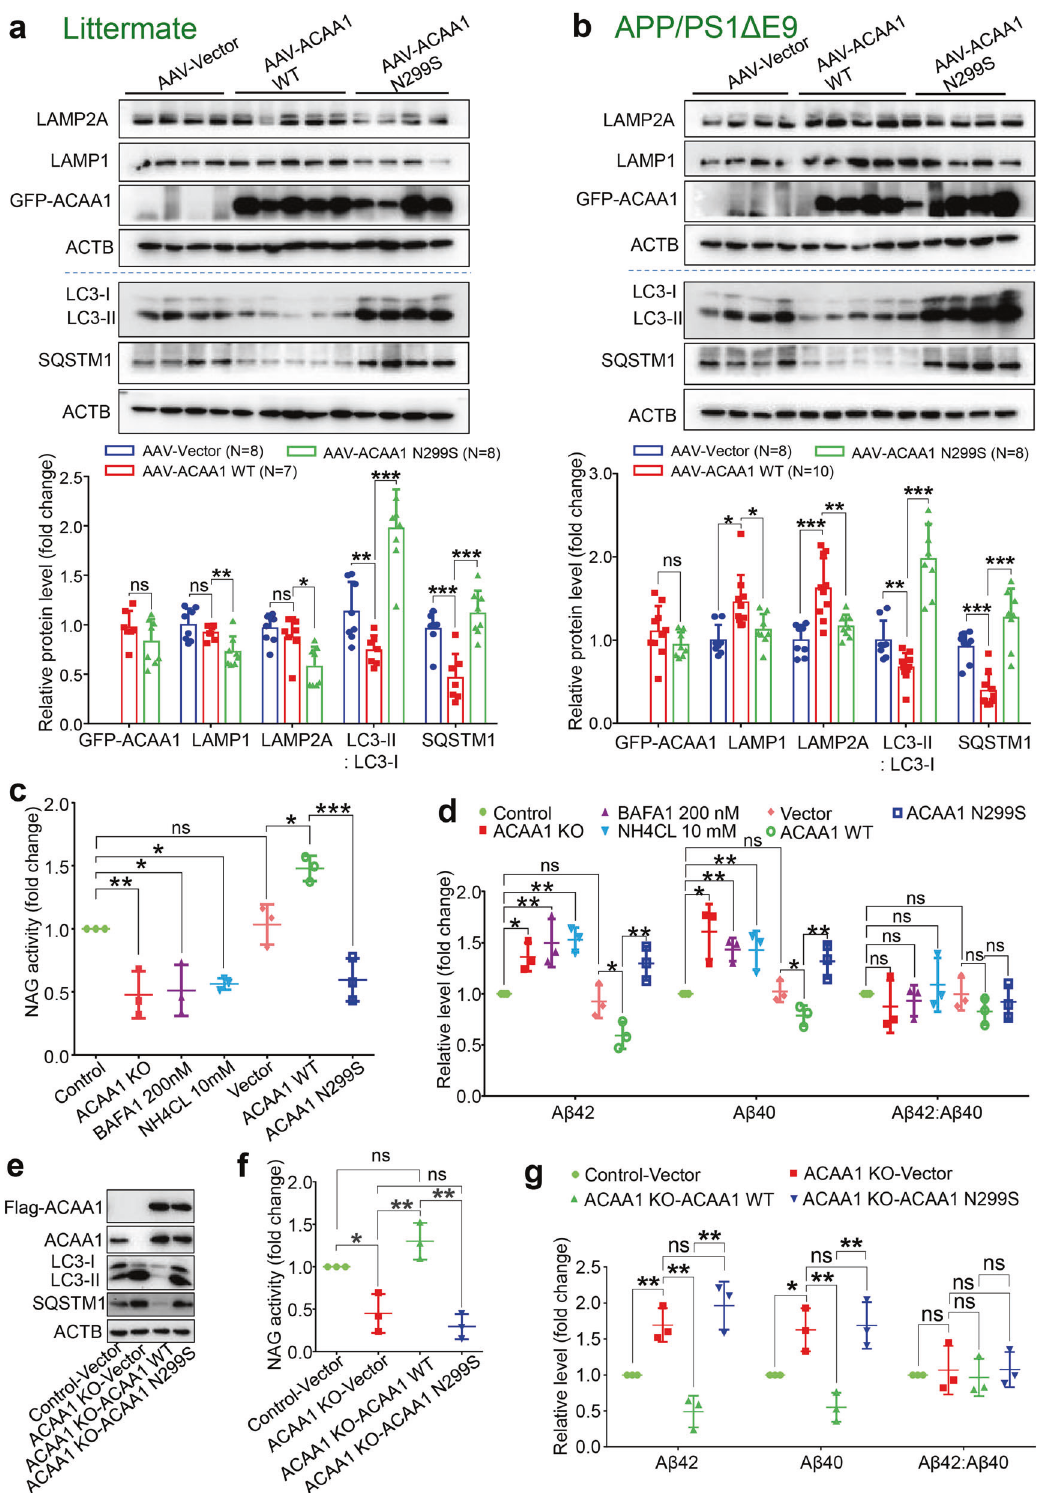
NMDAR in neurons, whereas ACAA1 p.N299S impaired this regulation possibly via altered levels of proteins involved in synaptic functions (Fig. 5) and/or a gain of toxic function. Focused experiments should be performed to test this hypothesis and to elucidate the underlying